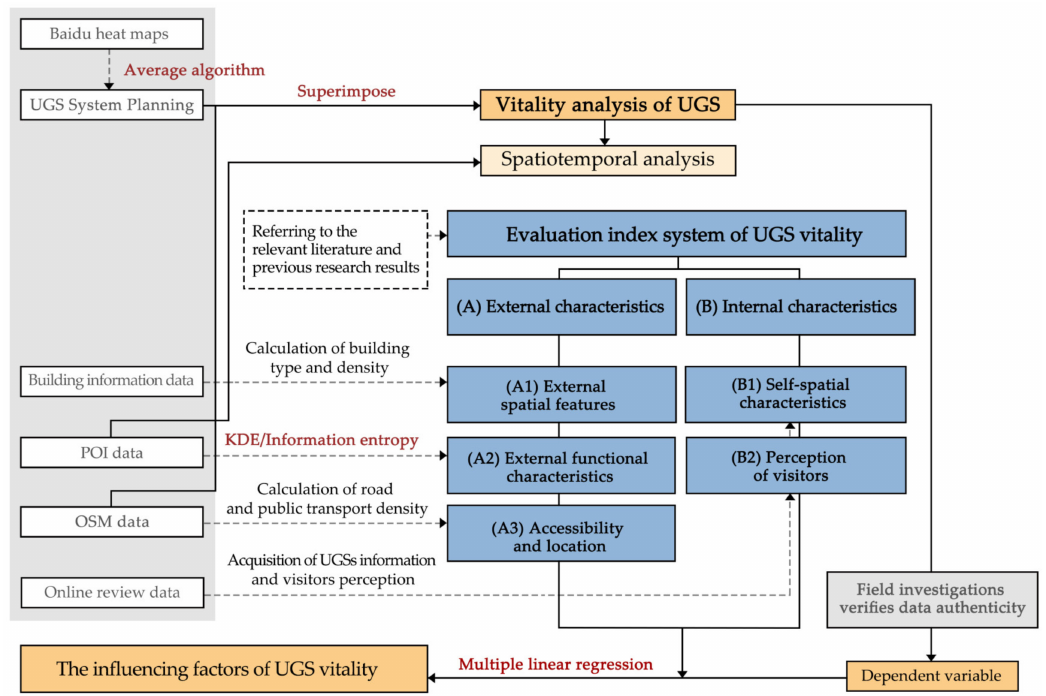
Figure 2. Identification process of the factors influencing UGS